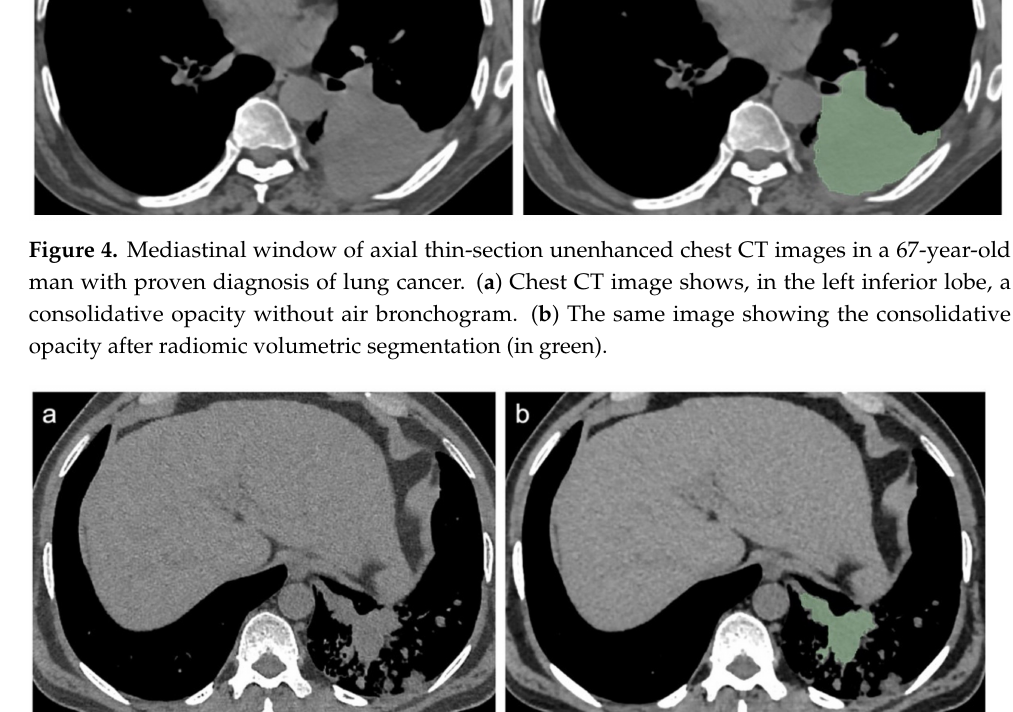
Figure 5. Mediastinal window of axial thin-section unenhanced chest CT images in a 84-year-old man with proven diagnosis of pulmonary tuberculosis. ( a ) Chest CT image shows, in the left inferior lobe, a consolidative opacity without air bronchogram. ( b ) The same image showing the consolidative opacity after radiomic volumetric segmentation (in